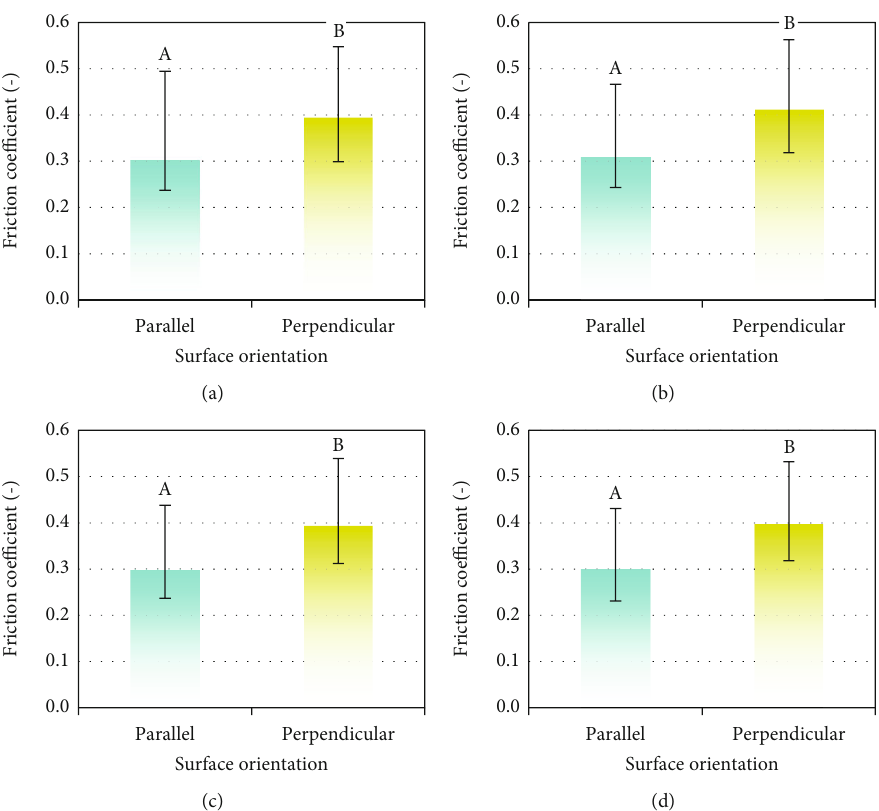
Figure 7: The coe ffi cient of static friction (mean value and minimum – maximum value) of cereal kernels on friction plates with di ff erent surface orientations: (a) barley; (b) oats; (c) rye; (d)